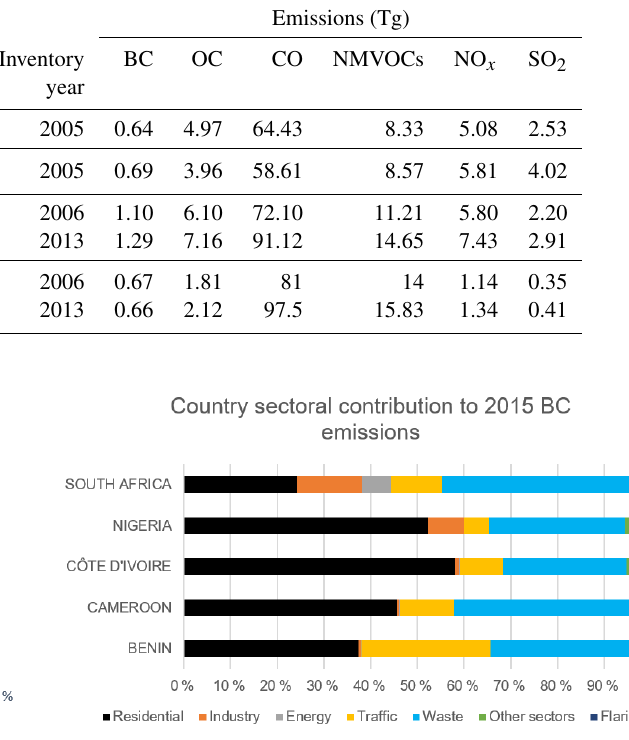
Figure 5. Sectoral contribution to 2015 BC emissions in some African